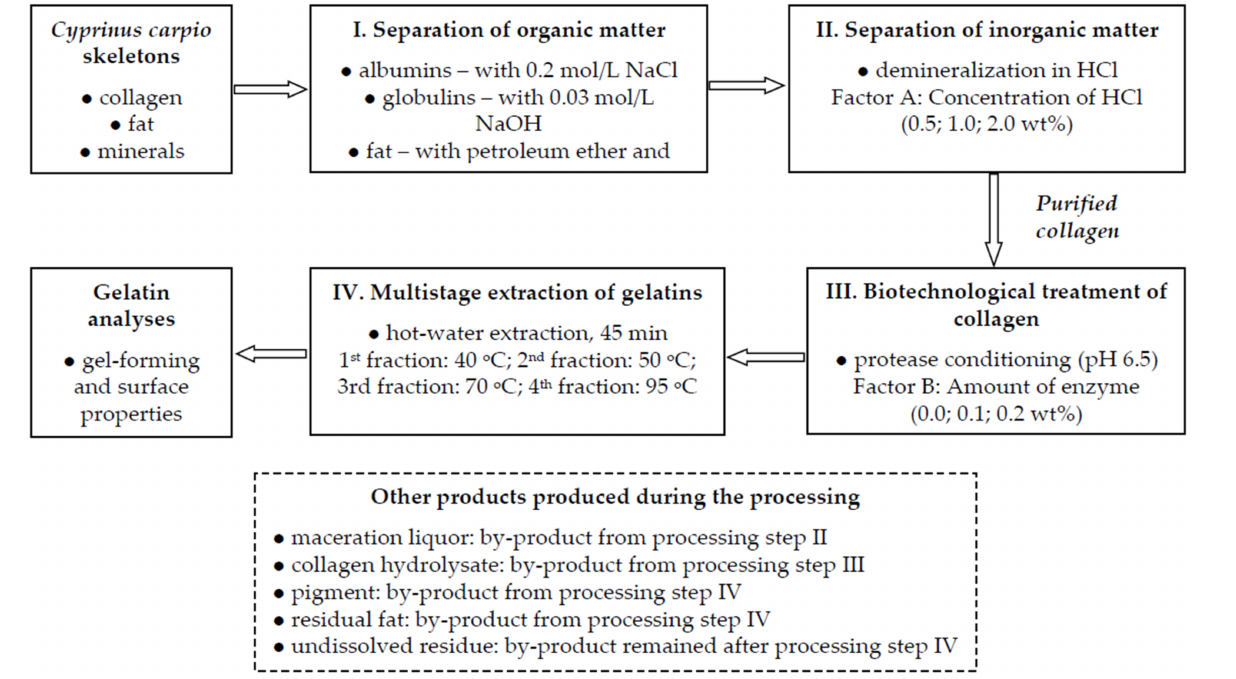
Scheme 1. Layout of processing of Cyprinus carpio skeletons into four gelatins fractions and other products which can be further